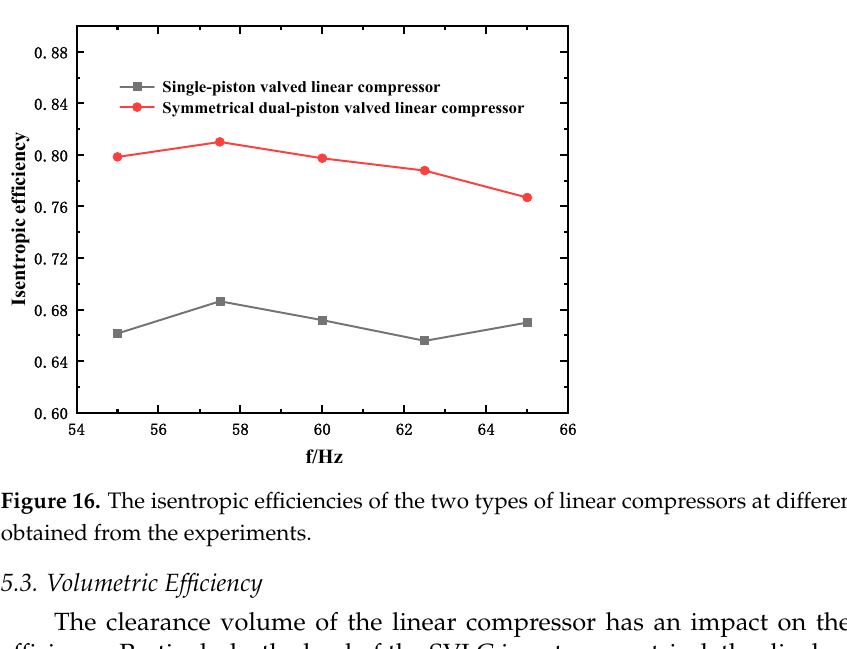
Figure 15. The isentropic efficiencies of the two types of linear compressors at different pressure ratios, obtained from the experiments.